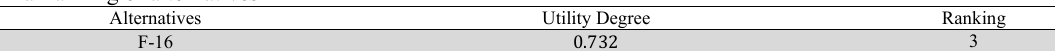
The final ranking of